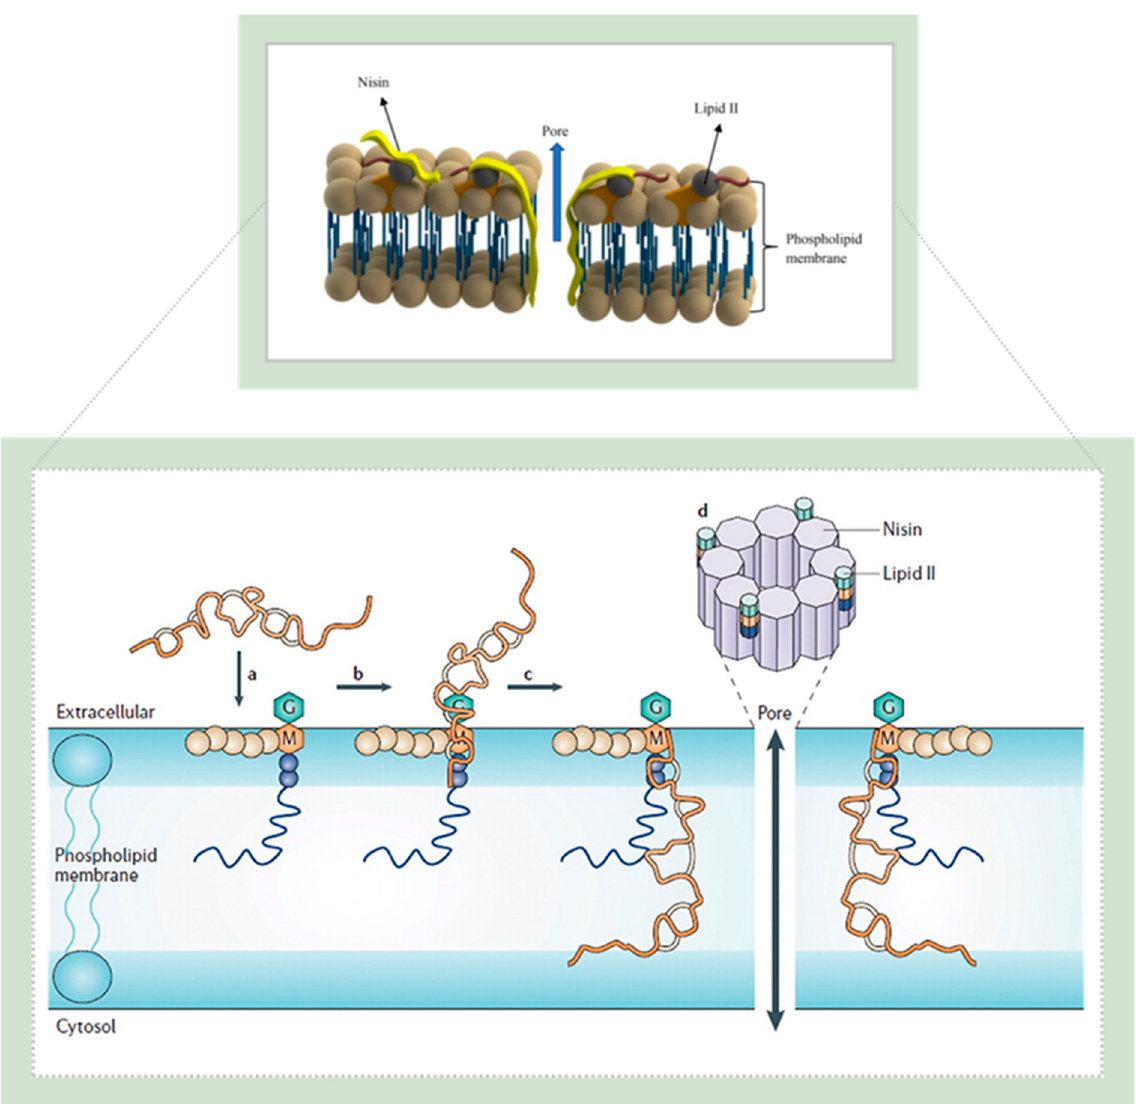
Figure 10. Schematic representation of the bactericidal mechanism of nisin: ( a ) nisin reaches the bacterial membrane; ( b ) adsorption of nisin to docking molecule (lipid II) via electrostatic interactions; ( c ) stable transmembrane orientation of nisin (cationic region of nisin interact with the negatively charged phospholipid heads, while the hydrophobic region of nisin interacts with the membrane core); ( d ) assembly of nisin-lipid II pore complex (consisting of 4 lipids II and 8 nisin molecules) (Reproduced with permission from [71,149], Elsevier, Amsterdam, The Netherlands, 2019 and Taylor & Francis, Abingdon, UK, 2016).